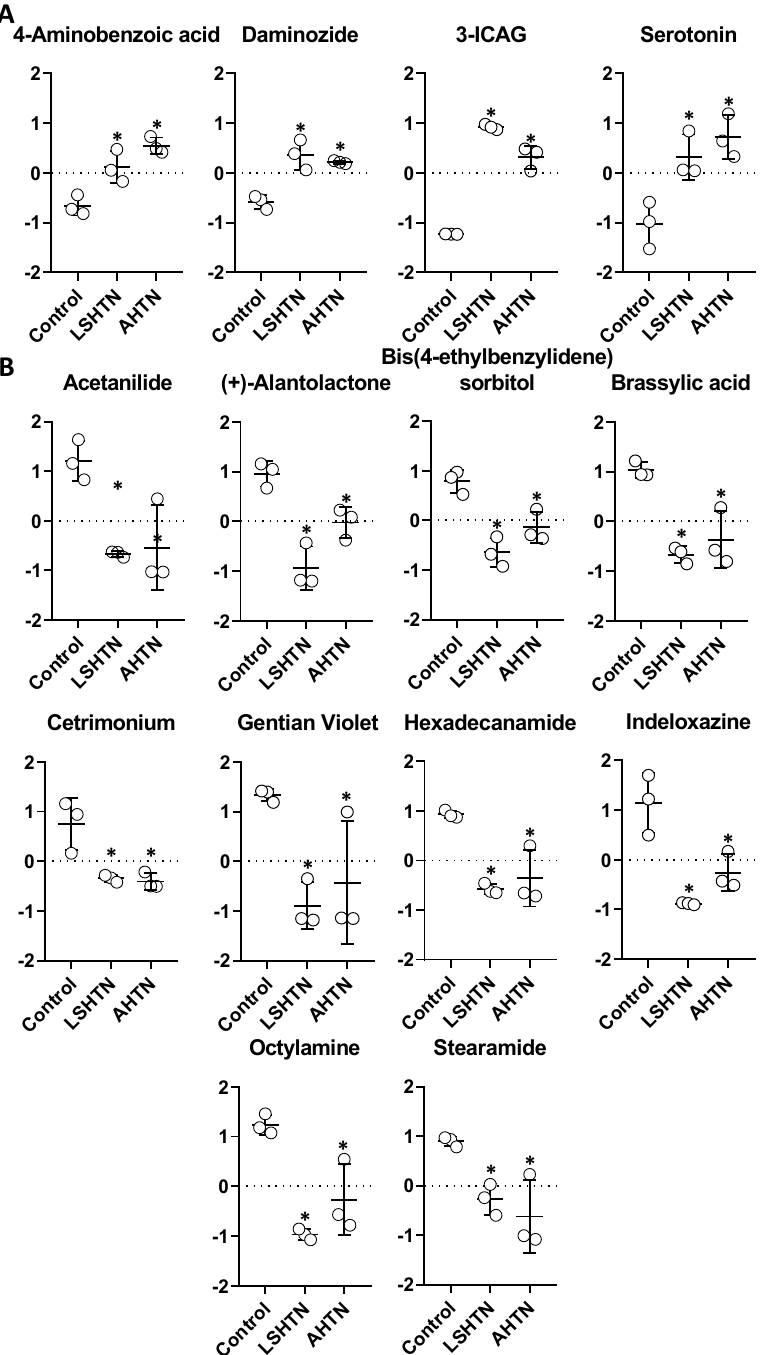
Figure 3. Common serum metabolites increased or decreased significantly in both LSHTN and AHTN mice compared to control mice. Serum metabolites that were significantly increased in both hypertensive groups are shown in ( A ). Serum metabolites that were significantly decreased in both hypertensive groups are shown in ( B ). * indicates p < 0.05 by one-way ANOVA. Data are plotted as fold changes in log transformed values of the normalized peak intensity values, ( n = 3).